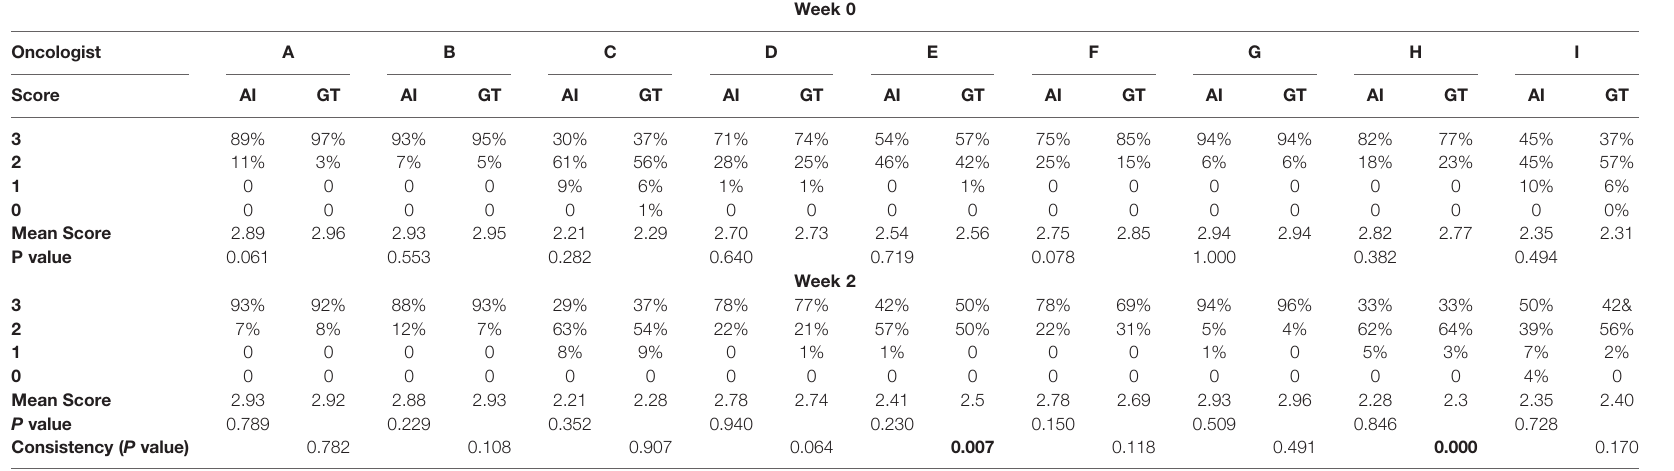
TABLE 3 | Graded oncologist evaluation for AI and GT